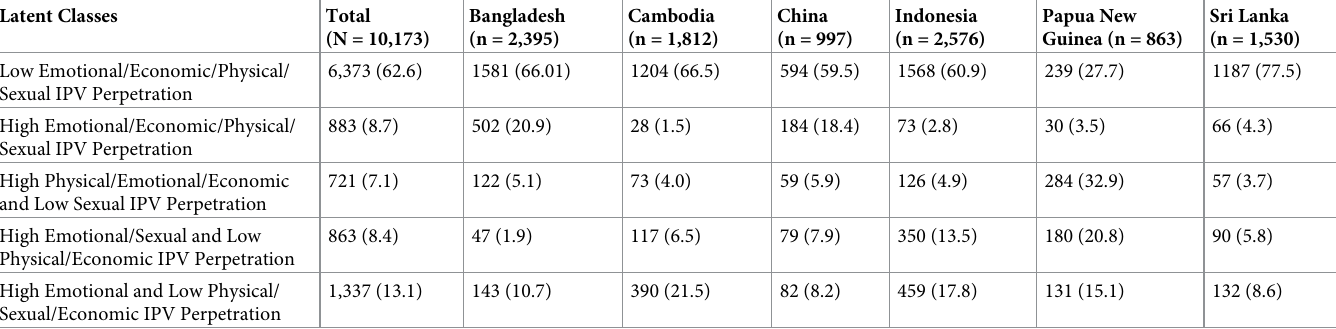
Table 2. Prevalence of latent class membership by country among male participants recruited for UN Multi-Country Study on Men and Violence. Latent